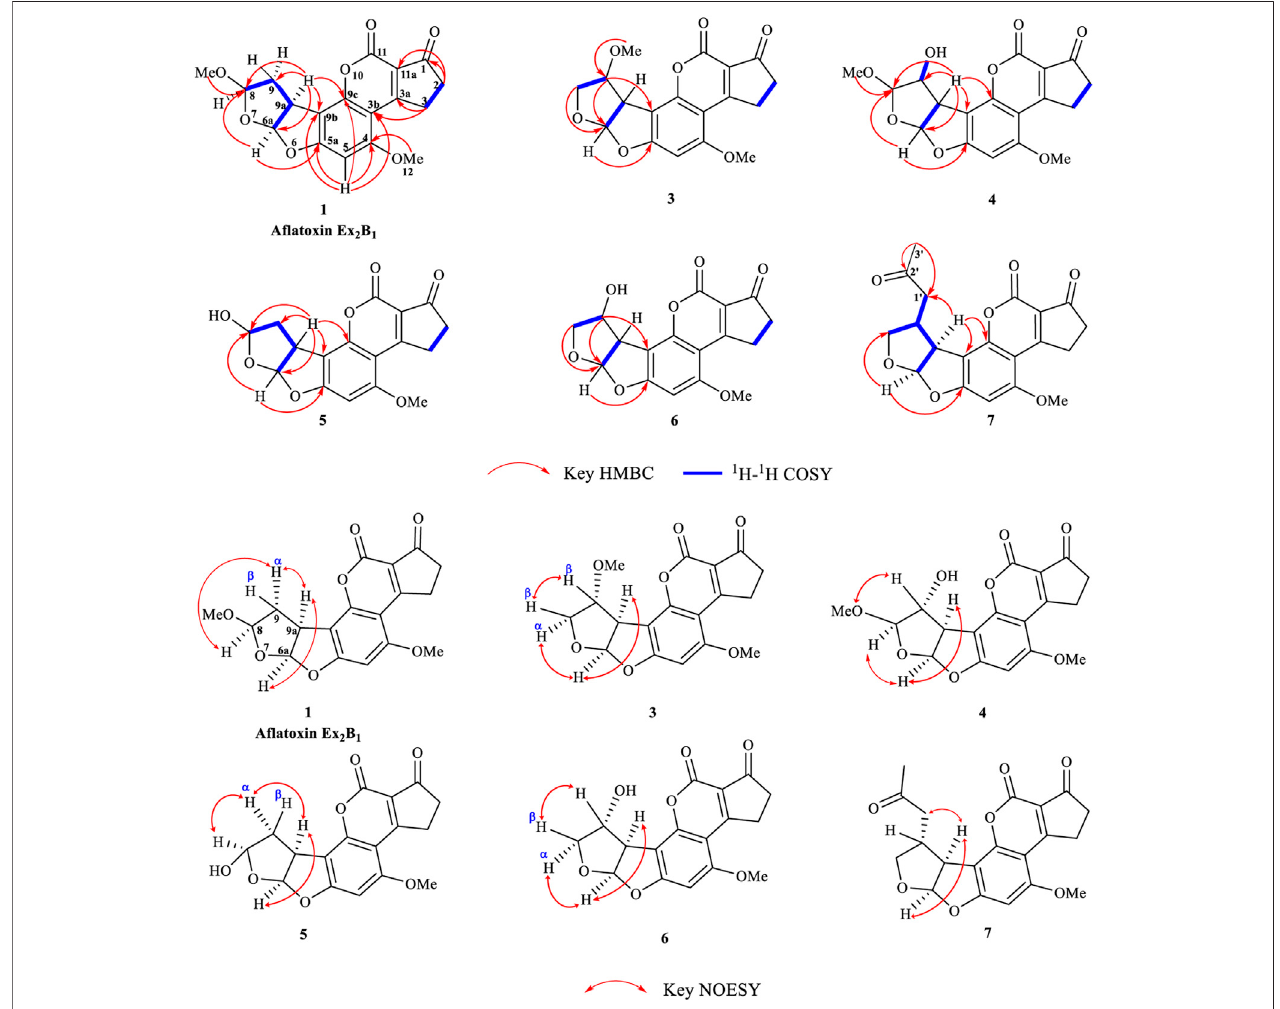
FIGURE 5 | Key 2D-NMR and NOESY correlations of 1 and 3-7